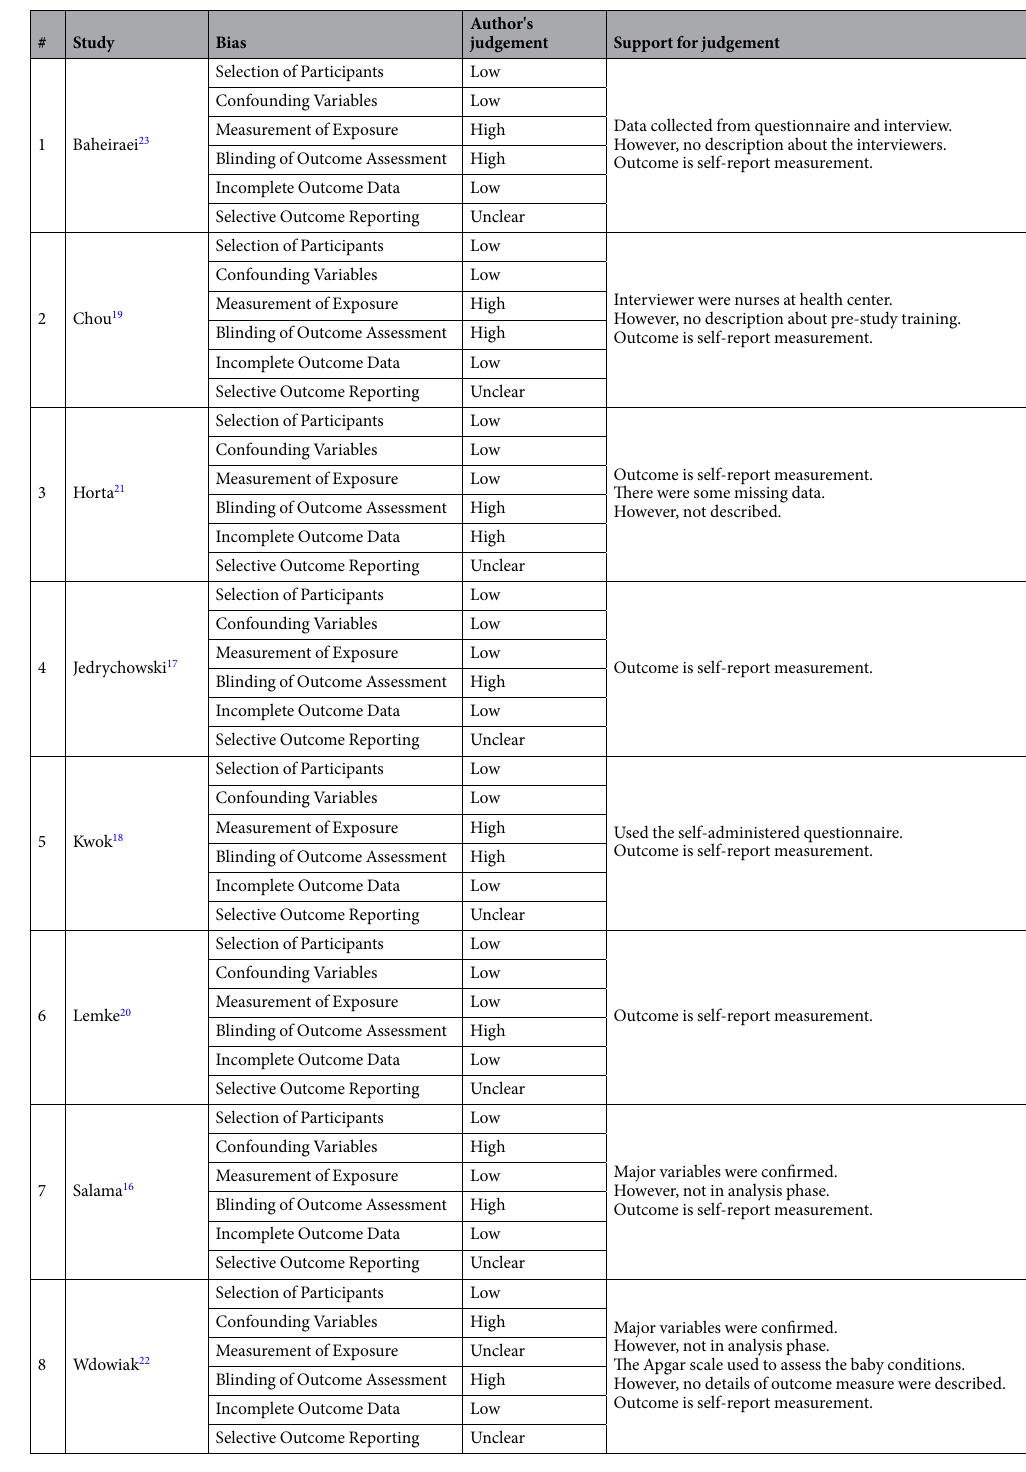
Table 2. Judgment of risk of bias